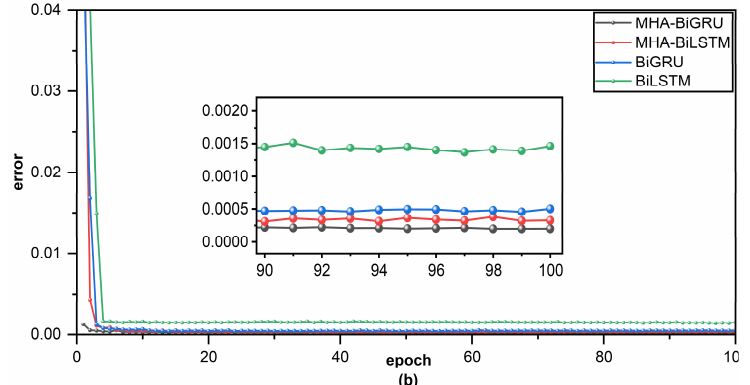
Figure 7. Comparative experiment loss value based on the MHA mechanism: ( a ) the combination of the MHA mechanism with RNN ( b ) the combination of the MHA mechanism with bidirectional RNN.